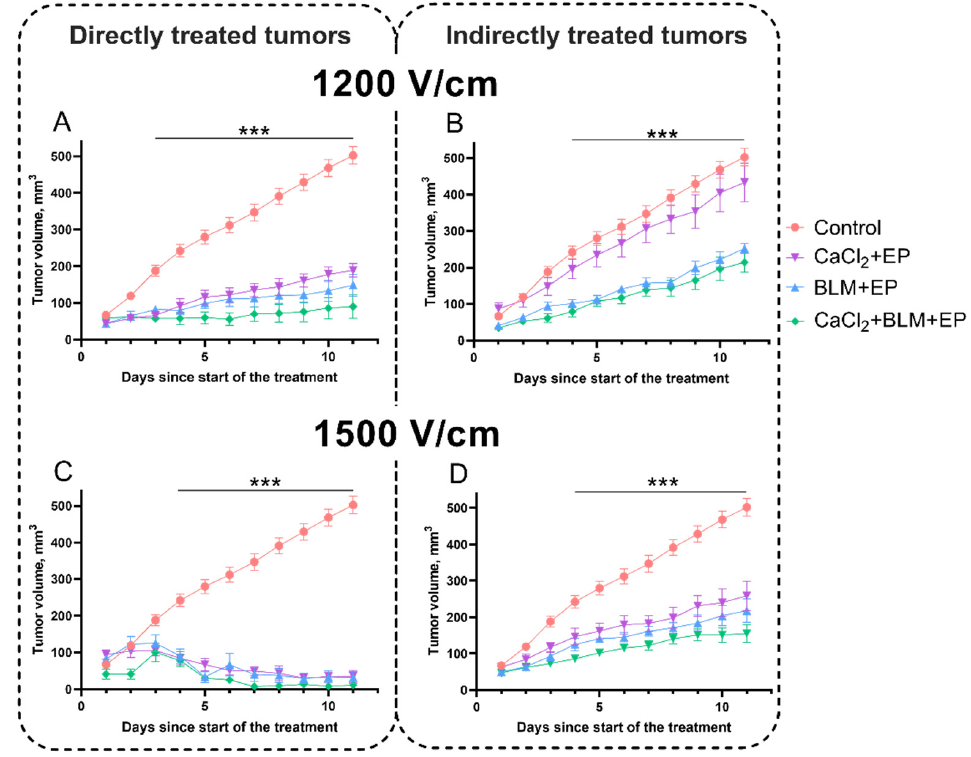
Figure 6. ( A ) Tumor growth changes in directly ( A , C ) and indirectly ( B , D ) treated tumors using bleomycin electrotransfer, calcium electroporation, or combination of both. Eight 1200 V/cm ( A , B ) and 1500 V/cm ( C , D ) 100 µ s duration pulses were used for tumor electroporation. Bleomycin solution (200 µ L, 470 µ M) was injected i.v., while into CaCl 2 solution (half of the tumor volume, 168 mM) was injected i.t. Statistical significance of the differences between experimental groups was evaluated using t -test. *** symbols represent statistical significance of differences between CaCl 2 + EP, BLM + EP, and CaCl 2 + BLM + EP compared to the control (no treatment), respectively ( p < 0.001). To find out whether the growth of directly and indirectly treated tumors can be inhibited further, we used stronger, 1500 V/cm electric field pulses. When tumors were treated with these pulses (in presence of bleomycin, CaCl 2 , or both), almost complete reduction of tumors was observed in all groups of directly treated tumors (Figure